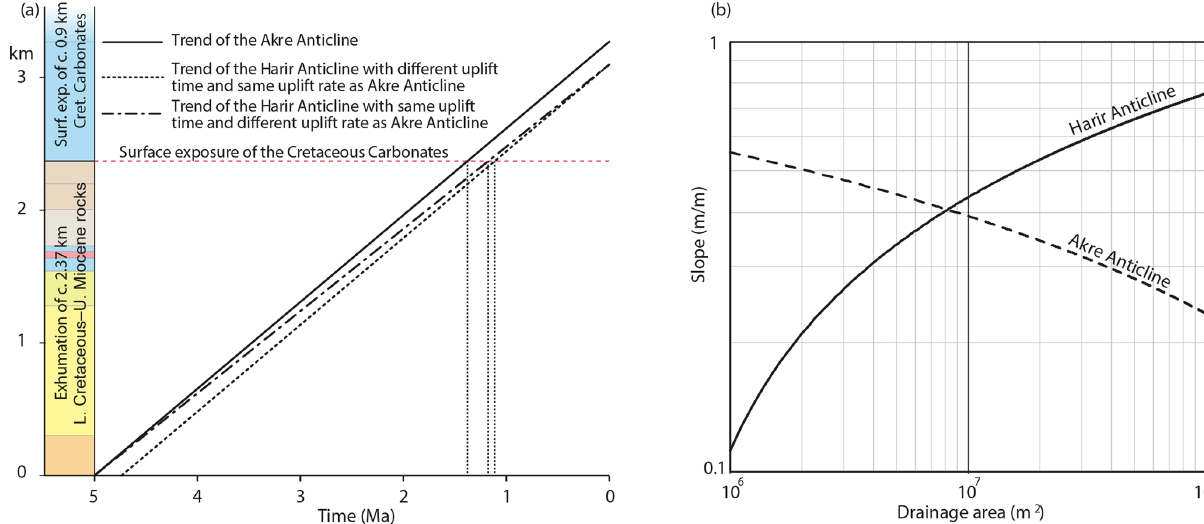
Figure 12. (a) Diagram showing the exposure time of the Upper Cretaceous carbonates in Akre and Harir Anticlines. Two different scenarios are plotted for Harir: having a slower uplift rate than Akre or onset of uplift later than Akre. (b) Channel slope–drainage area plots for streams in both Akre and Harir